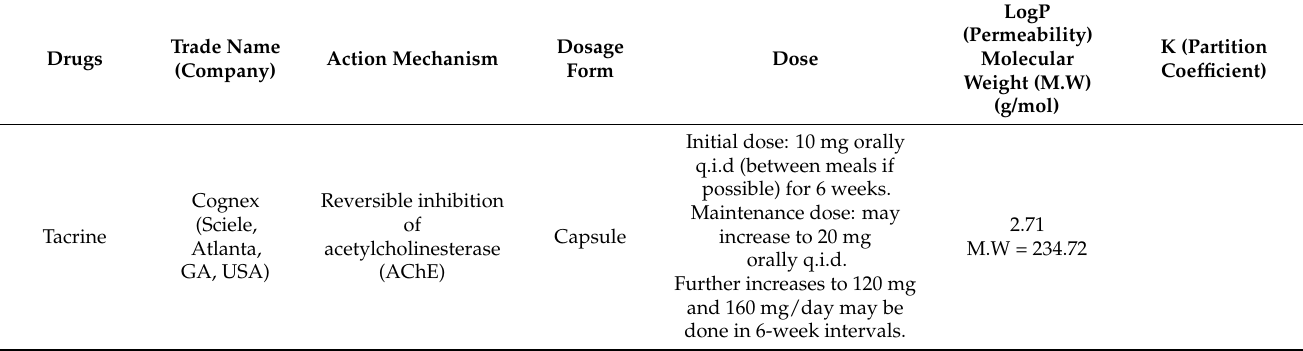
Table 1. Commercially available drugs for the treatment of